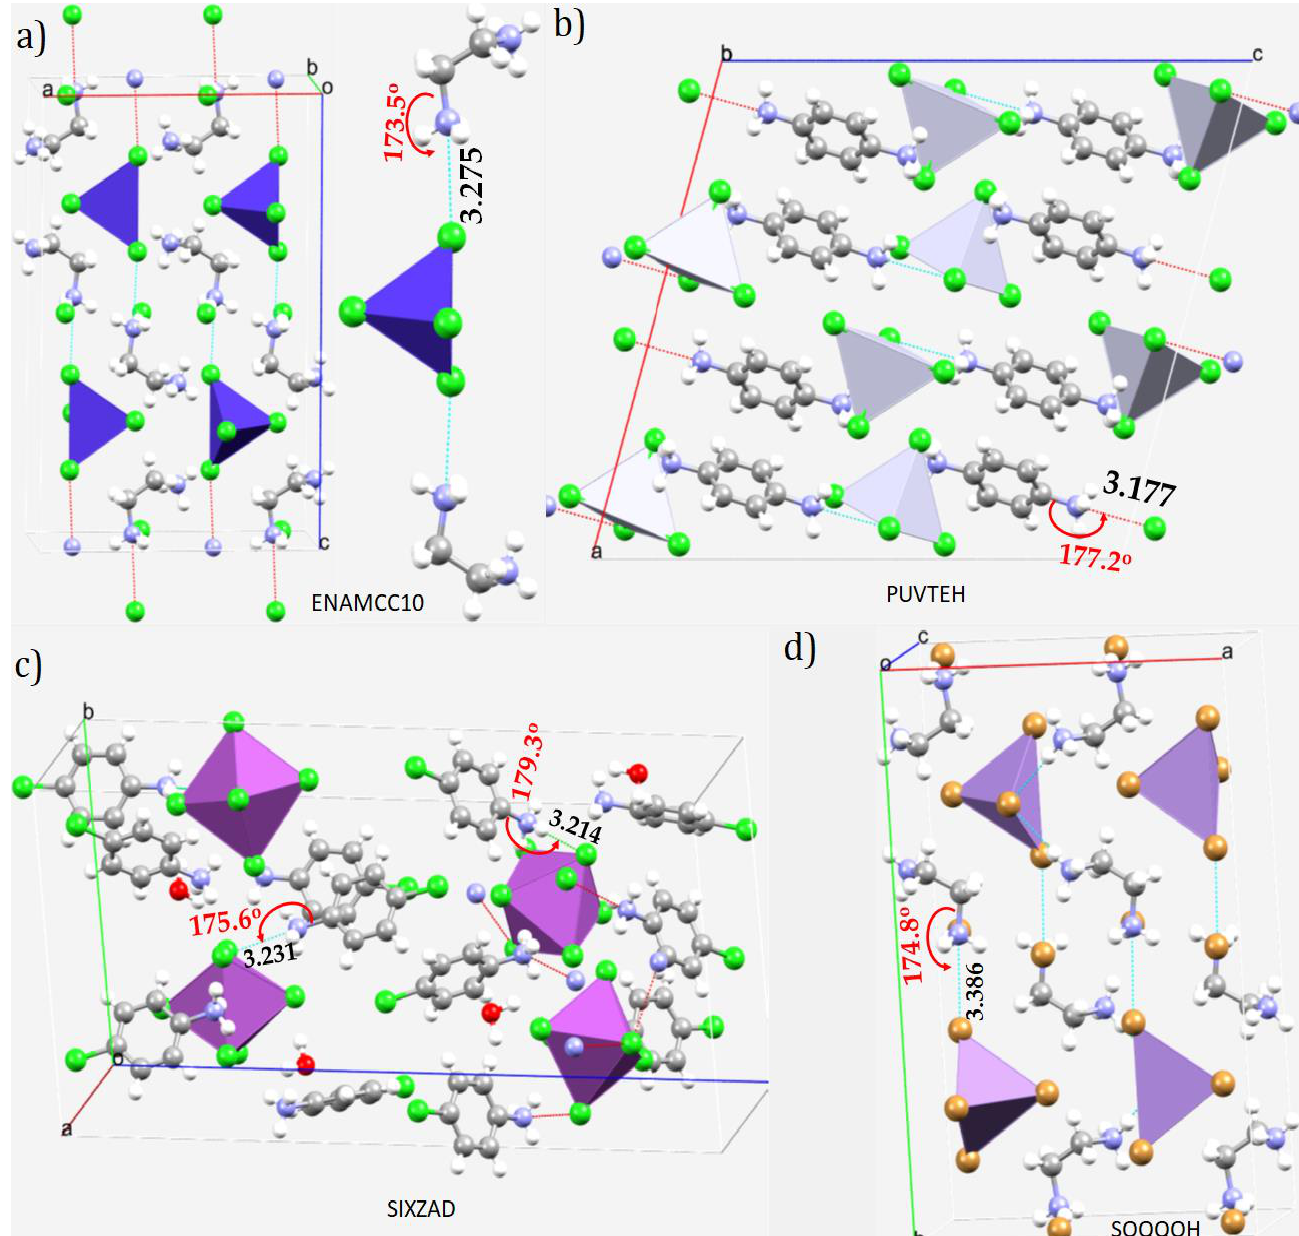
Figure 25. Ball-and-stick and polyhedral models of some selected 0D crystal structures. ( a ) bis(ethylenediammonium) tetrachloro-cobalt(II) bis(chloride), [CoCl 22 − ][C 2 H 10 N 22+ 2 ][Cl − ] 2 [163]; ( b ) 1,4-phenylenediammonium tetrachloro-mercury(II) (C 6 H 10 N 2 ) 2+ (HgCl 42 − ) [164]; ( c ) tris(4-chloroanilinium) hexachloro-bismuth monohydrate [3(C 6 H 7 ClN + ) 3 (BiCl 63 − )(H 2 O) [165]; ( d ) bis(ethane-1,2-diaminium) bis(bromide) tetrabromo-manganese (C 2 H 10 N 22+ ) 2 ,(MnBr 2 − )(Br − ) 2 [166]. Intermolecular contacts between bonded atomic basins are illustrated as dotted lines in cyan and hanging contacts in red. Selected bond distances and bond angles associated with the nitrogen-centered pnictogen bonds are in Å and degrees, respectively. The tetrahedra hybrid structure of (C 6 H 10 N 2 ) 2+ (HgCl 42 − ), Figure 25b [164], shows two dimensional interwoven inorganic-organic layers bound through N-H ··· Cl hydrogen bonding interactions. Organic layers are accommodated between Cl ··· Cl halogen bonded inorganic layers with Cl ··· Cl distance = 3.628(3) Å and ∠ Hg-Cl ··· Cl=157.8(9) ◦ . The